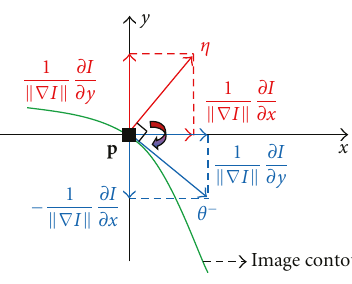
Figure 1: η and θ − vectors at point p .